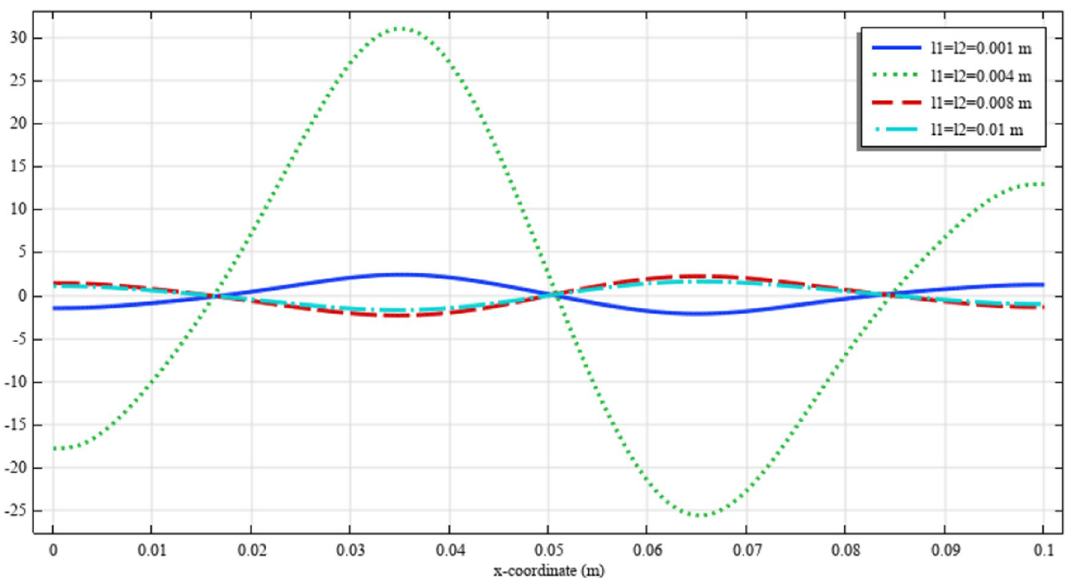
Figure 8. The displacement u x ( x , b / 2 )/ | u 0 | for different values of ℓ 1 and ℓ 2 (COMSOL